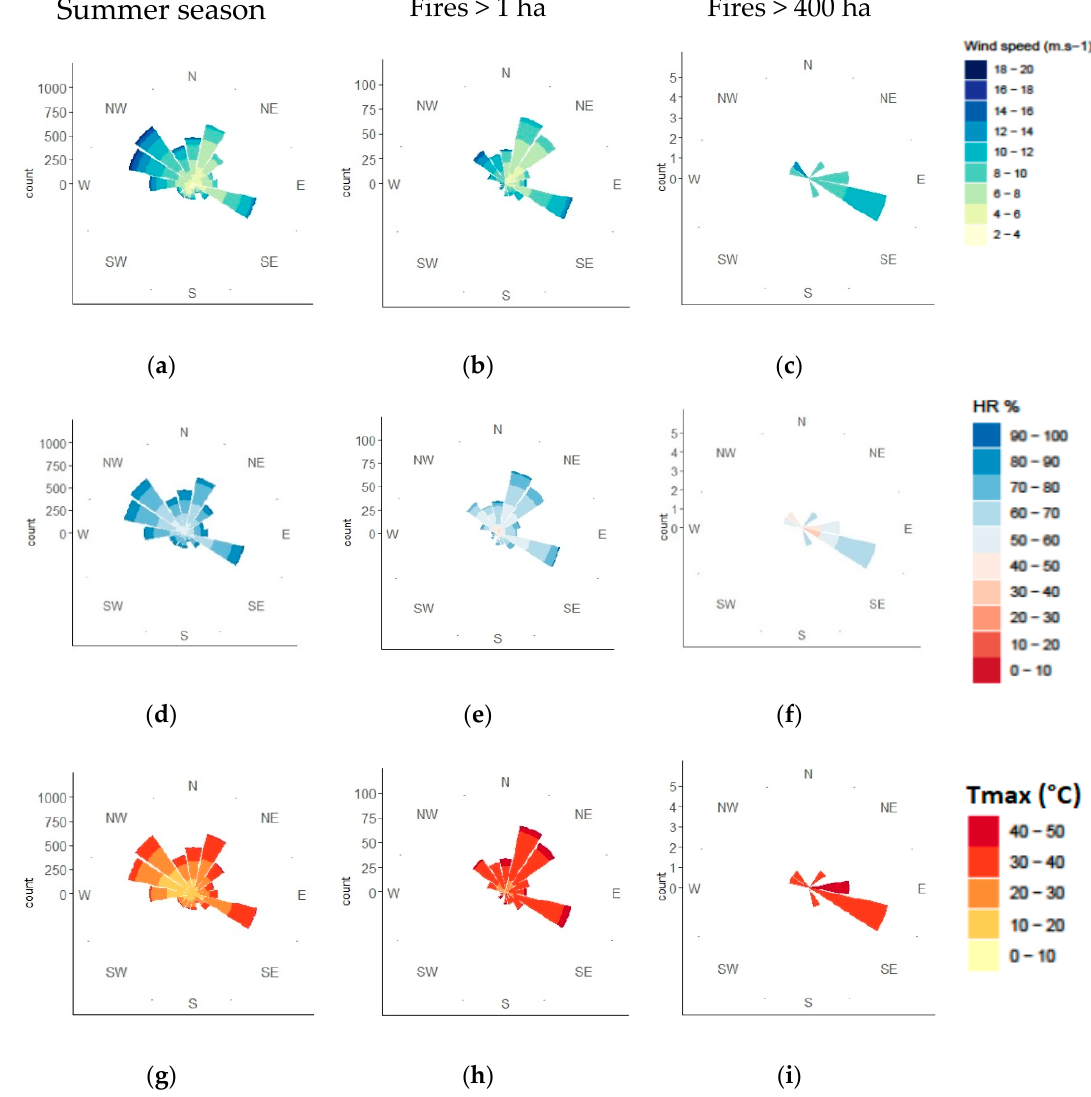
Figure 3. Wind roses representing the frequency distribution of wind directions during the fire season ( a , d , g ), small fires ( b , e , h ), and large fires ( c , f , i ), and the frequency of associated weather variables values for wind speed (WS in m·s − 1 ) ( a , b , c ), air relative humidity (HR in %) ( d , e , f ), and maximum air temperature (T max in °C) ( g , h , i ) in each wind direction.